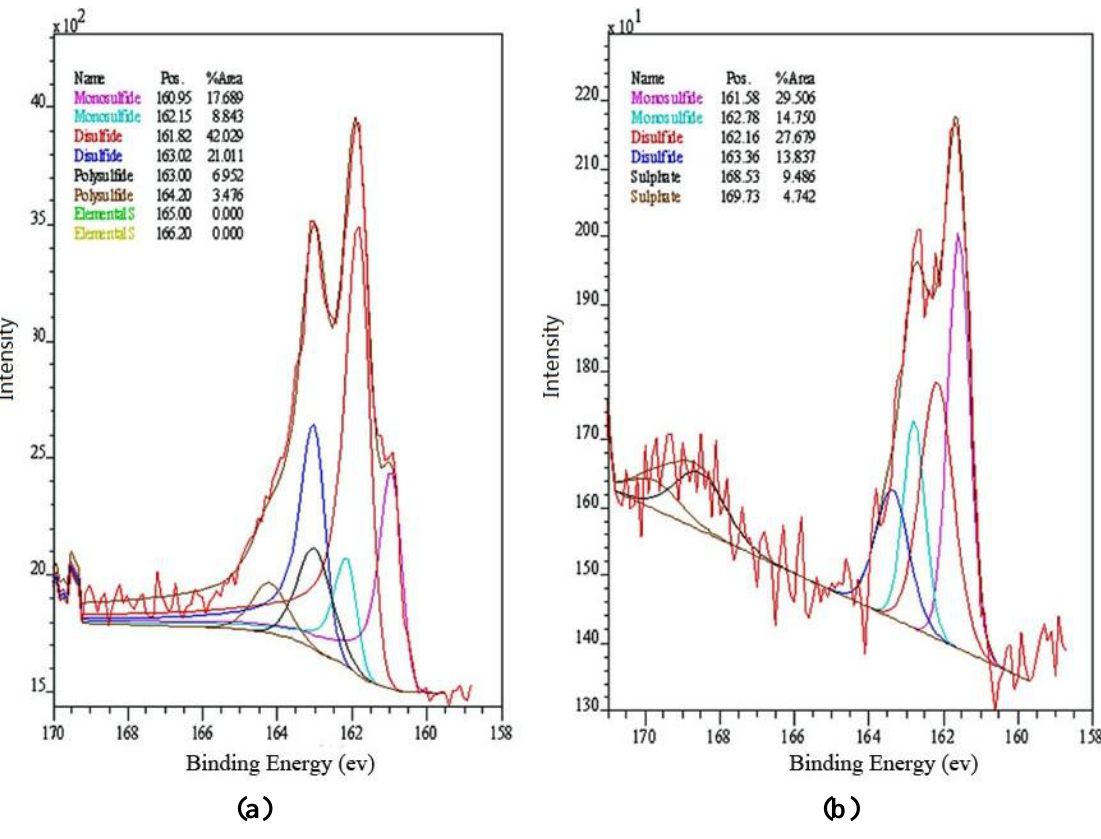
Figure 3. The S2p spectra from djurleite powder reacted in ( a ) 350 ppm ammonia; and ( b ) 700 ppm ammonia.